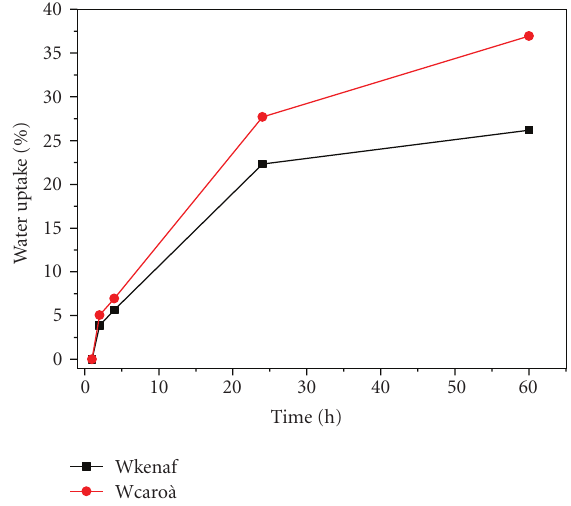
Figure 1: Moisture uptake % of caro`a and kenaf fibers. Figure 2: Absorption/desorption tests on 40wt.% soy/kenaf com-